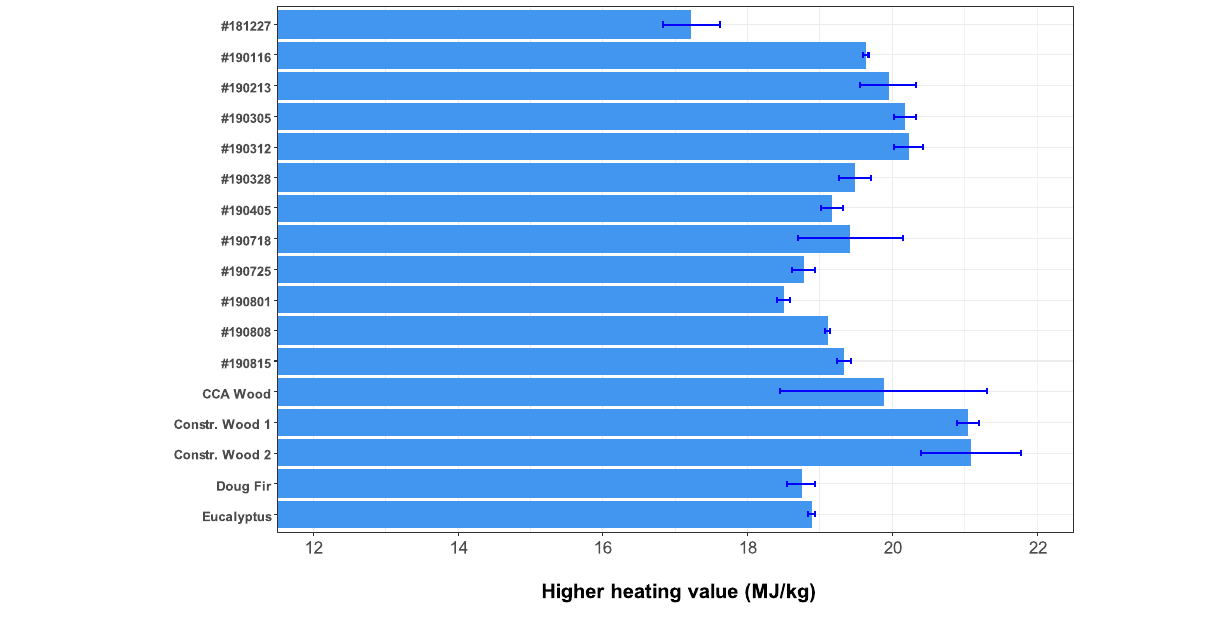
FIGURE 4 | Higher heating values of CCDWDF materials and reference woods.